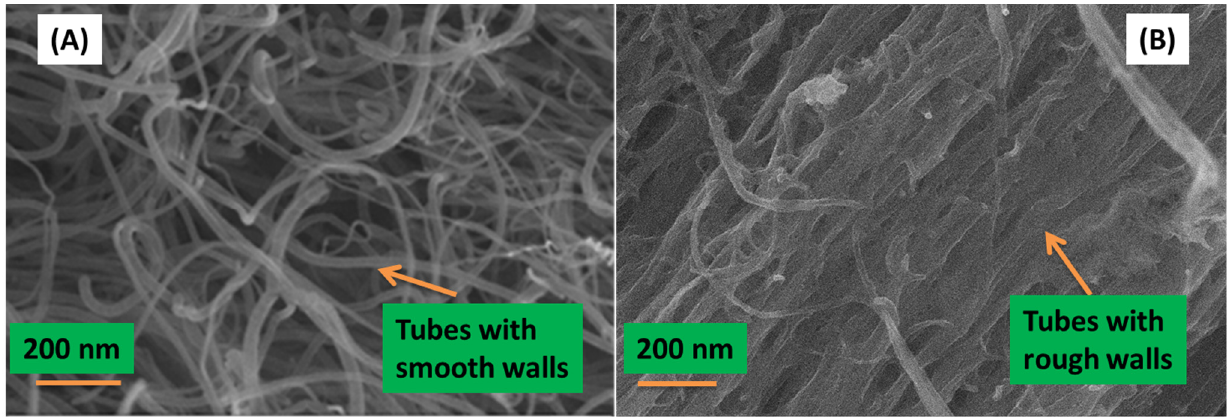
Figure 2. Morphology of ( A ) N-CNTs; and ( B ) nanocomposite of N-CNTs/P3HT synthesized by in situ